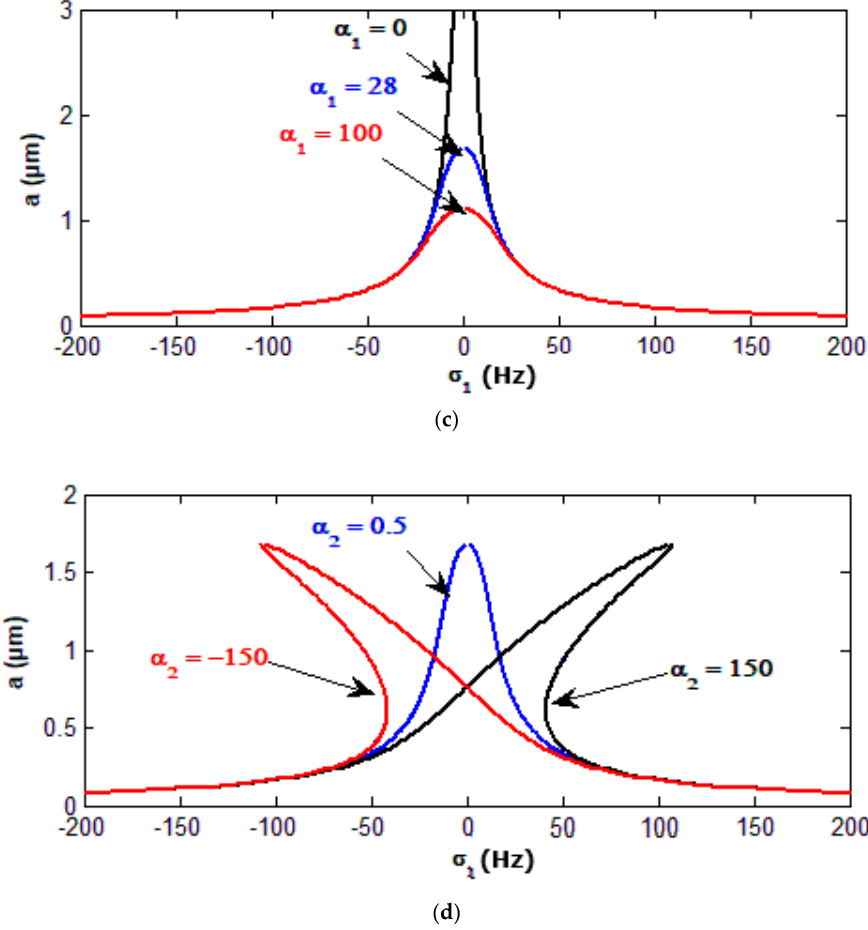
Figure 4. ( a ) The curves of frequency response for the controlled system without and with NPD control. ( b ) The curves of frequency response for the controlled system at some of the wind force f a . ( c ) The curves of frequency response for the controlled system at some values of the gain α 1 . ( d ) The curves of frequency response for the controlled system at some values of the gain α 2